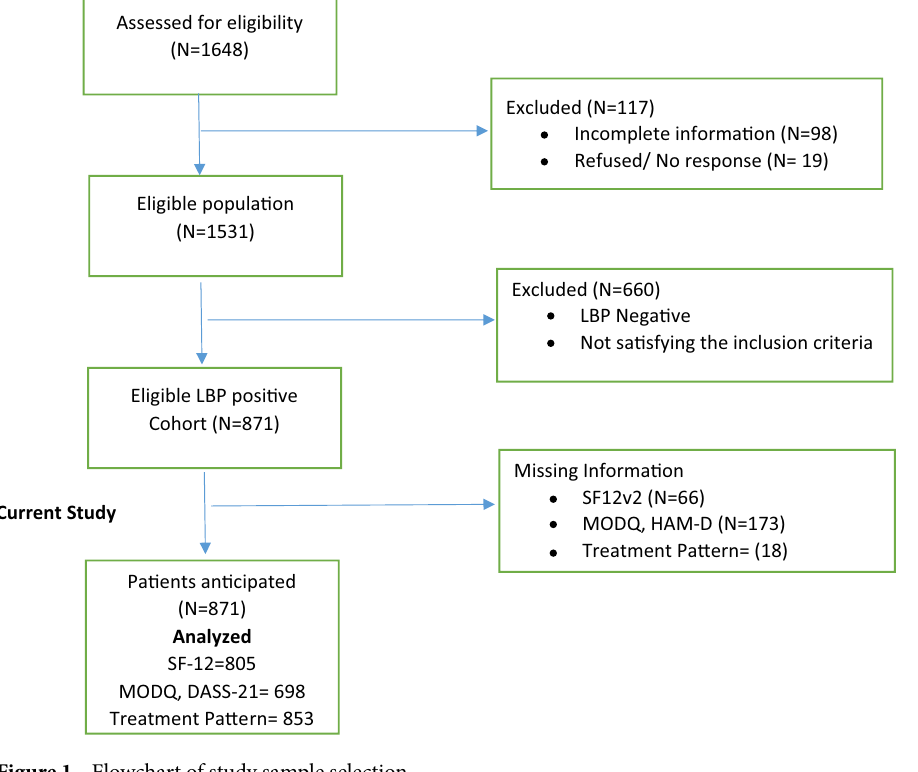
Figure 1. Flowchart of study sample